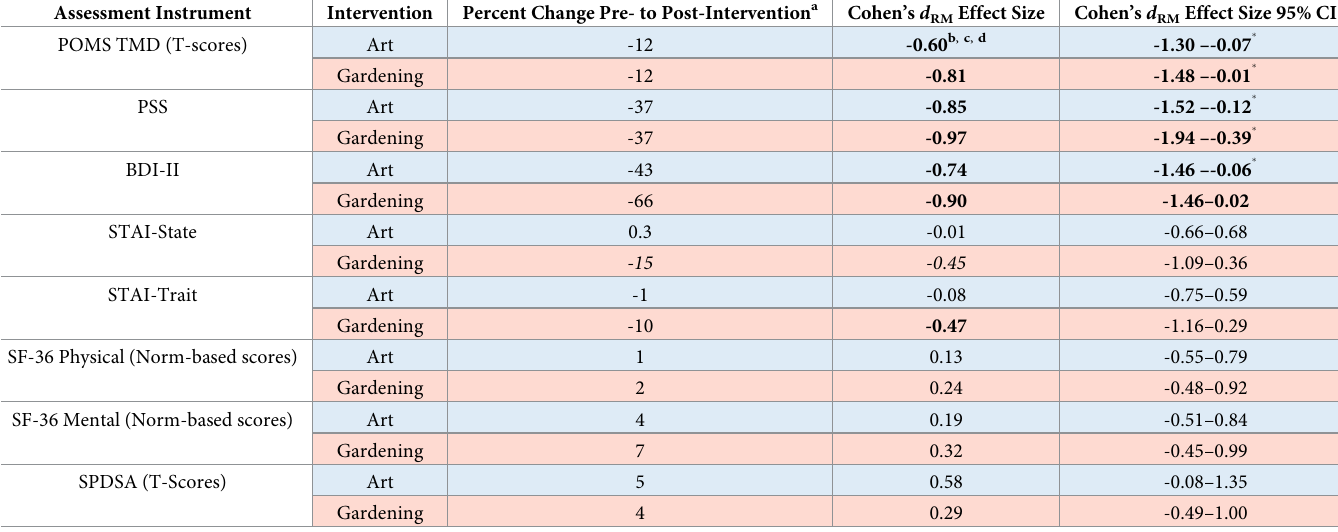
Table 6. Treatment effect size calculations using Cohen’s d RM for repeated